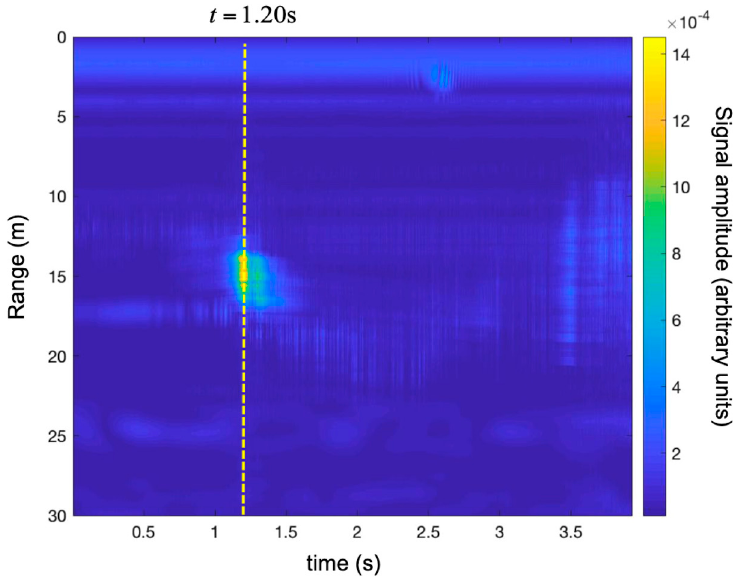
Figure 23. Detection of a small UAV using a SFCW radar. Time-range map with the Doppler correction during maneuver 2 (i.e., rapid take-off).